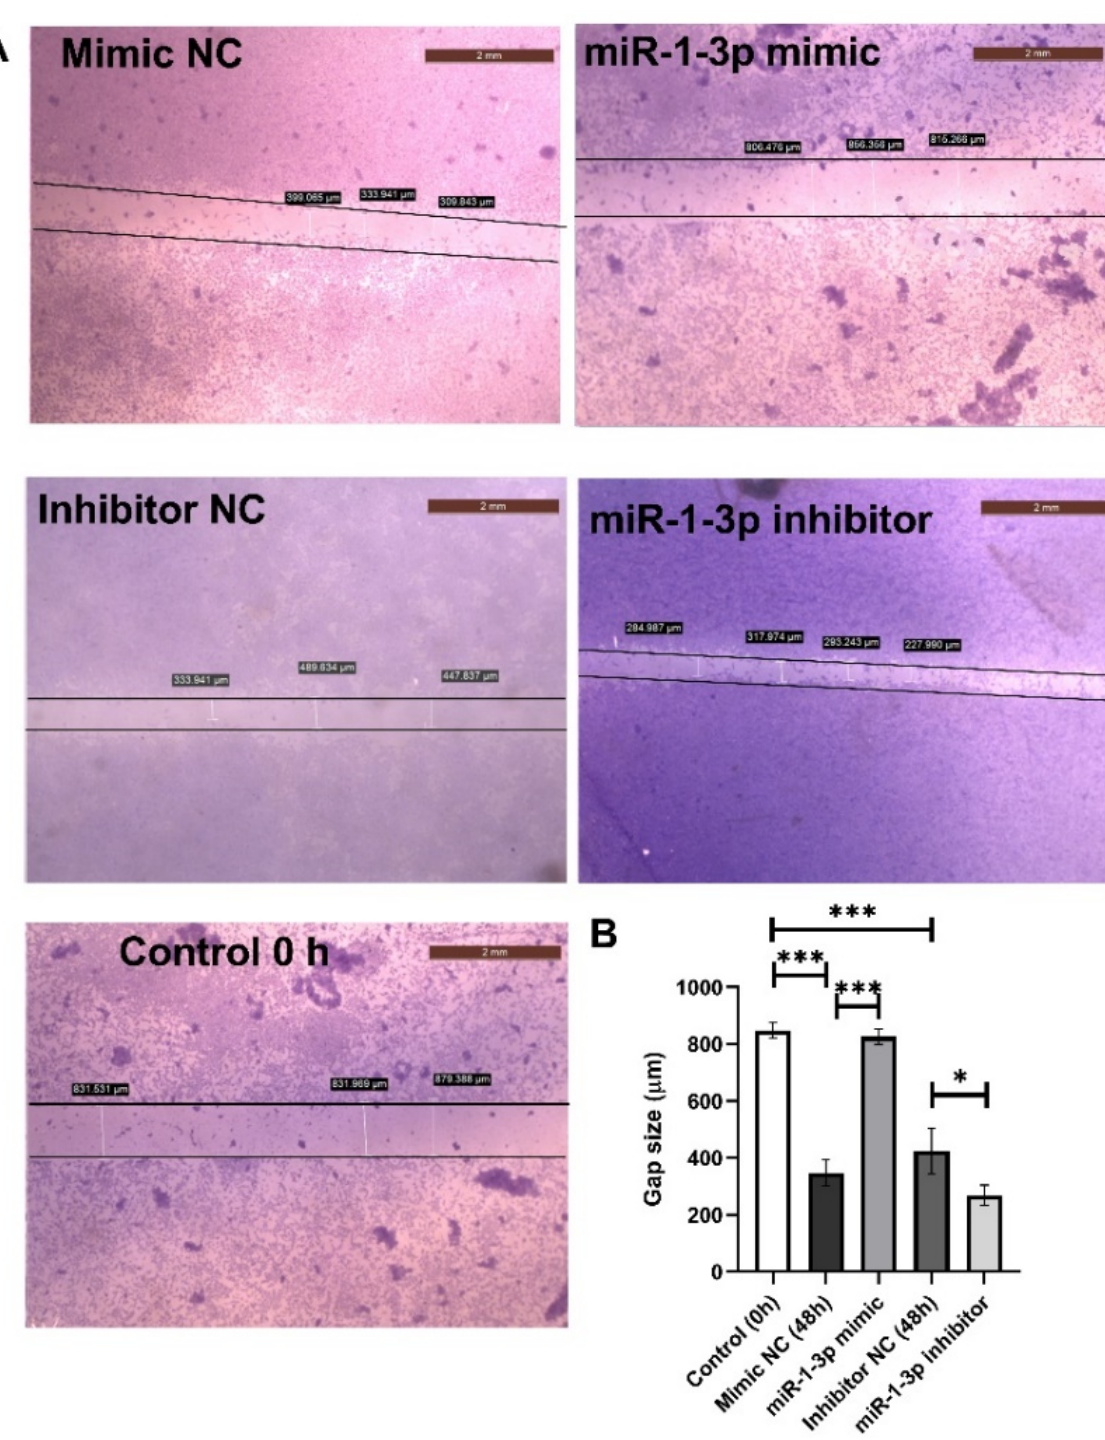
Figure 4. Effect of miR-1-3p mimic and inhibitor on cell migration in HepG2 cells. Representative